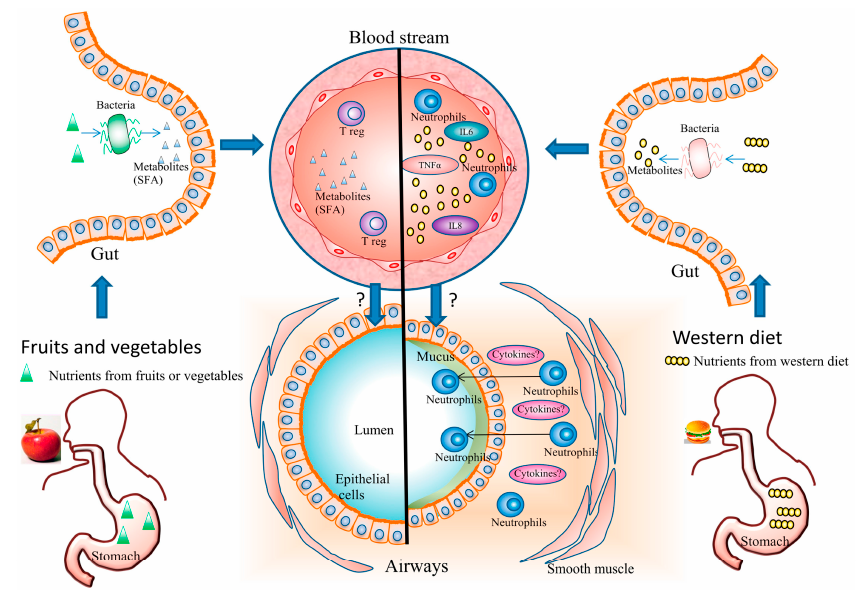
Figure 2. Systemic and airway effects of dietary patterns on asthma. The Western diet promotes a pro-inflammatory environment and causes an increase in airway inflammation. Fruit and vegetable consumption has systemic anti-inflammatory properties, with a decrease of pro-inflammatory cytokines in plasma. Fruit and vegetables are also associated with lower airway inflammation and a reduction of neutrophils in asthmatics. Gut microbiota plays a role in immune response to diet in asthma. Metabolites such as short-chain fatty acids (SCFA) (including ω -3 fatty acids) that have immunomodulatory effects are produced in high amounts after fruit and vegetable intake. The western diet altered microbiota composition and potentiate inflammation.